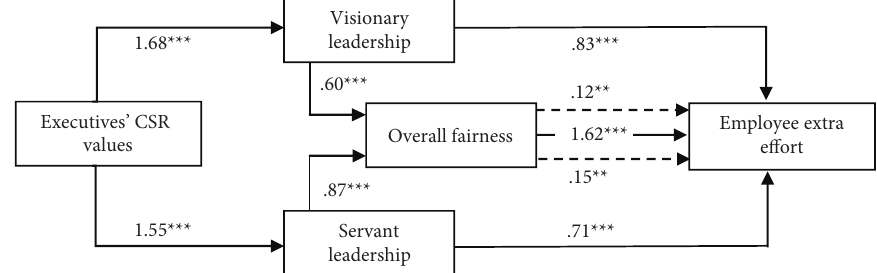
Figure 2. The structural model. The dotted line represents the mediated paths (H5 and H6). *** p < 0.001; ** p <